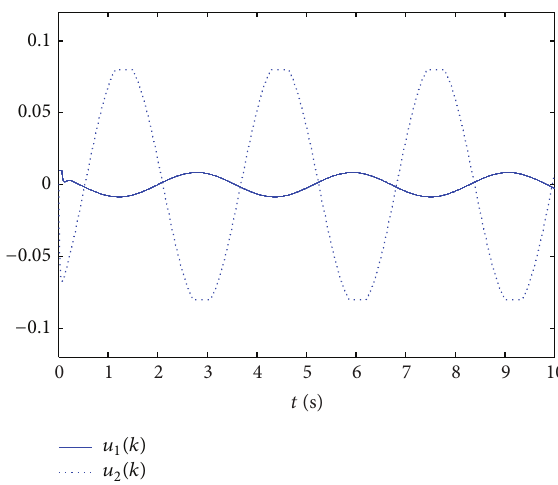
Figure 14: The control inputs 𝑢 1 (𝑘) and 𝑢 2 (𝑘)